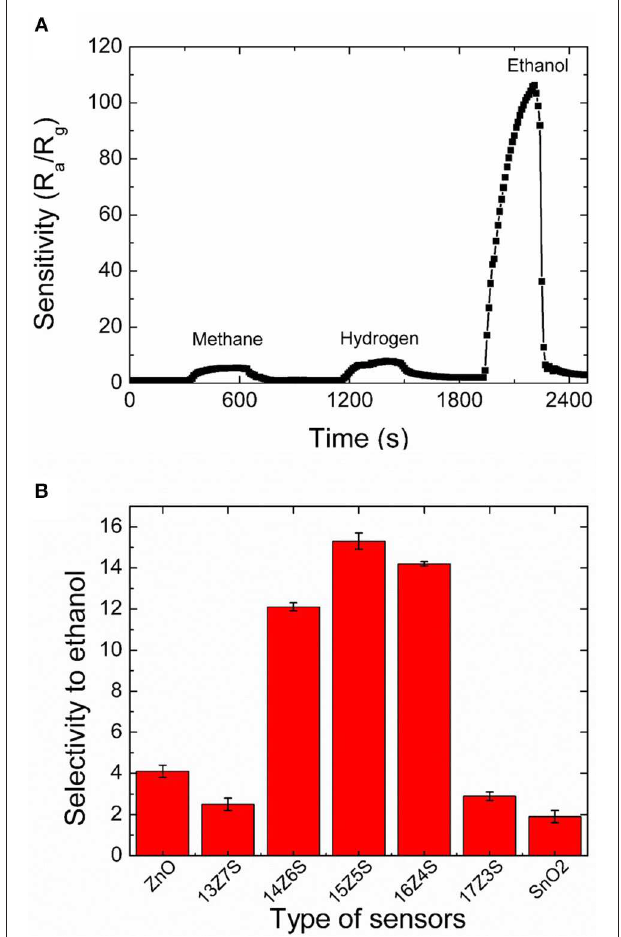
FIGURE 5 | (A) Selectivity of 15Z5S film sensors toward 50 ppm of methane, hydrogen and ethanol at an operating temperature of 400 ◦ C and (B) the variation of selectivity (ratio between the sensitivity of 50 ppm ethanol and hydrogen at 400 ◦ C) of the sensors fabricated with different films.